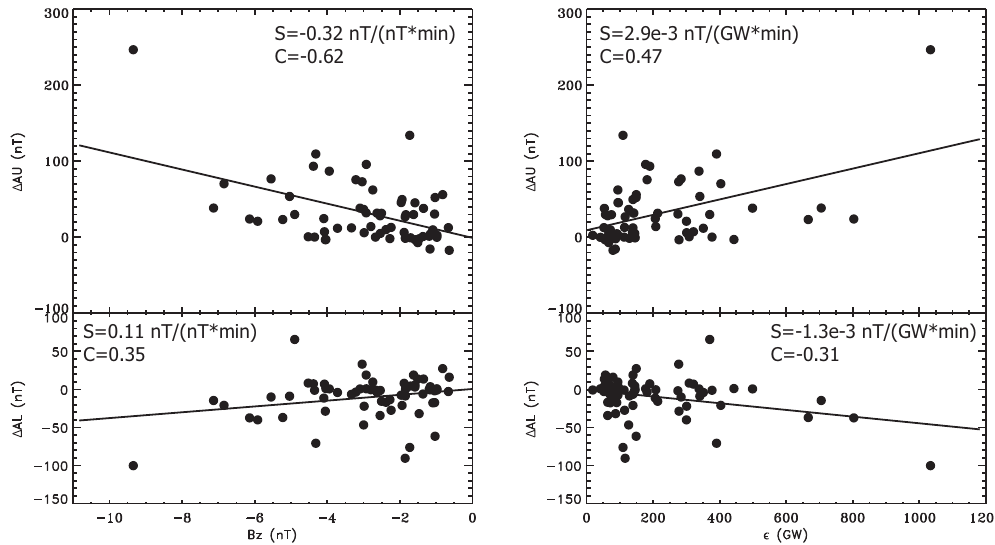
Fig. 8. Change in AU/AL at T =35min relative to T =0 min plotted as a function of median B z and median ε . The median is calculated for the time interval T =0 to T =35min.